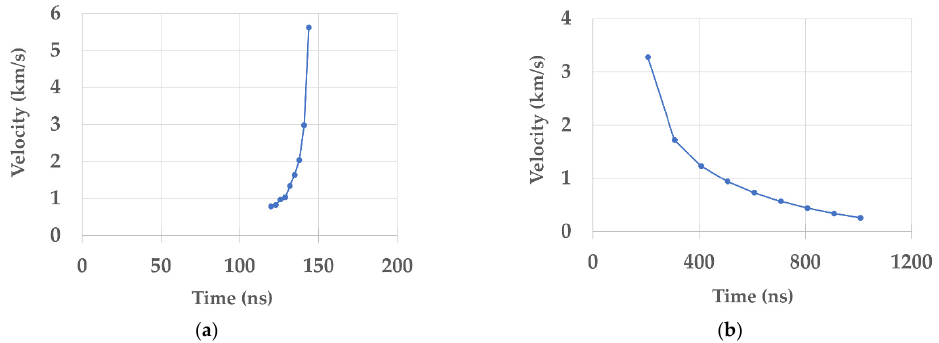
Figure 13. Streamer velocity (km/s) as a function of time (ns) in the 1st case: ( a ) streamer propagation in oil; ( b ) streamer travel along the oil–OIP interface.